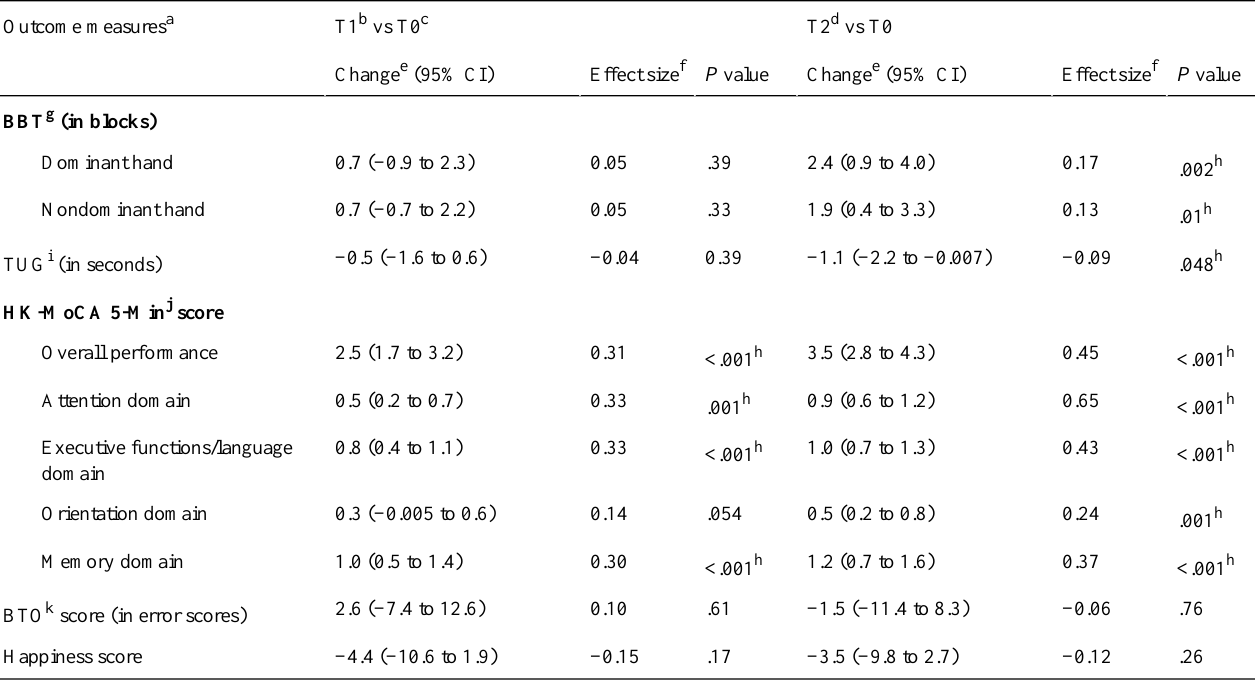
Table 8. Change in health outcomes over the three assessment time points.